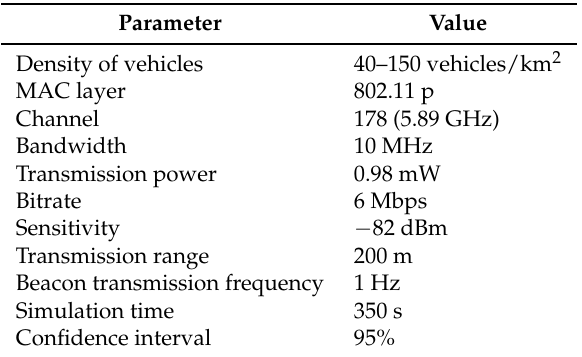
Table 3. Simulation